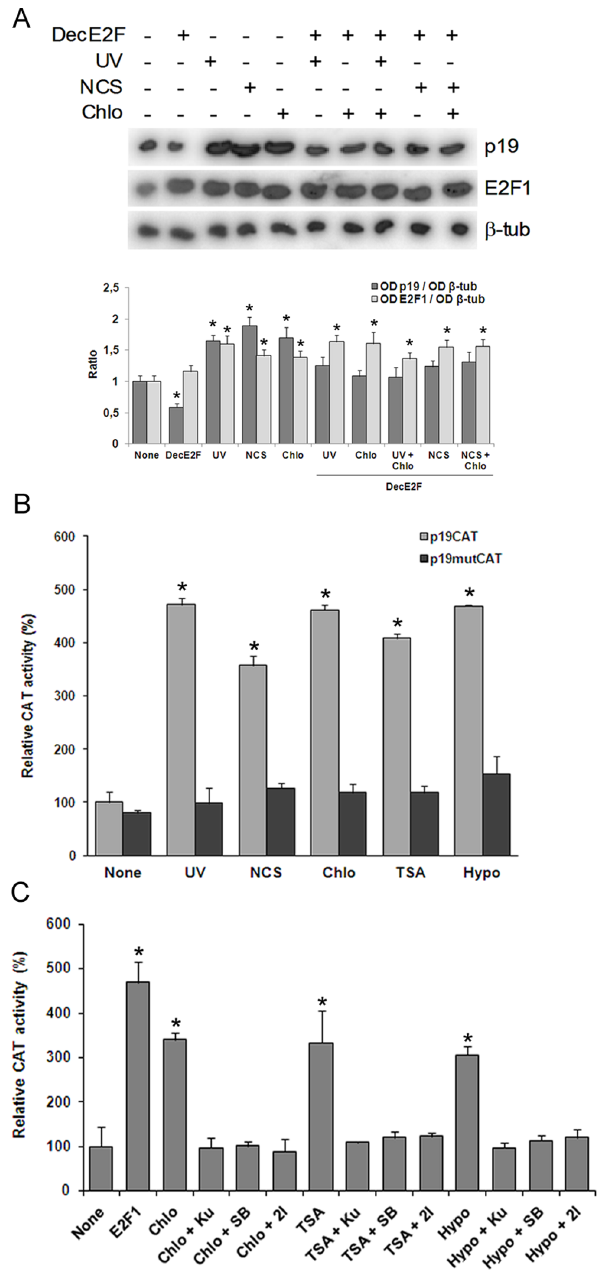
Figure 4. E2F mediates induction of p19 in response to DNA damage or chromatin relaxation. A. HEK-293 cells were transfected with 500 nM E2F decoy oligonucleotide. Twenty four hours later, cells were exposed to 40 J/m 2 UV or 50 ng/ml NCS and incubated in the presence or in the absence of 100 m M chloroquine. After 4 h, cells were harvested and subjected to northern blot analysis using a 32 P-labelled probe specific for human p19 mRNA and reprobed for E2F1 and b - tubulin mRNA. Figure shows a representative autoradiograph of three independent experiments with similar results. Densitometric analysis of p19 and E2F1 are represented in the lower panel. Bars represent the mean 6 S.E of three experiments. Student’s t -test was used to compare treated and non-treated samples (* p , 0.05, at least). B. HEK-293 cells transiently cotransfected with 4 m g of p19CAT, or equivalent amount of mutant plasmid, containing the 5 9 -flanking region of p19 gene